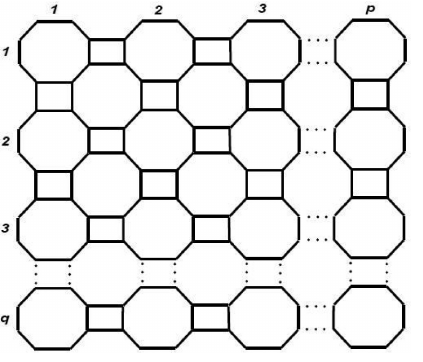
Table 2: Edge partition of T 1 C